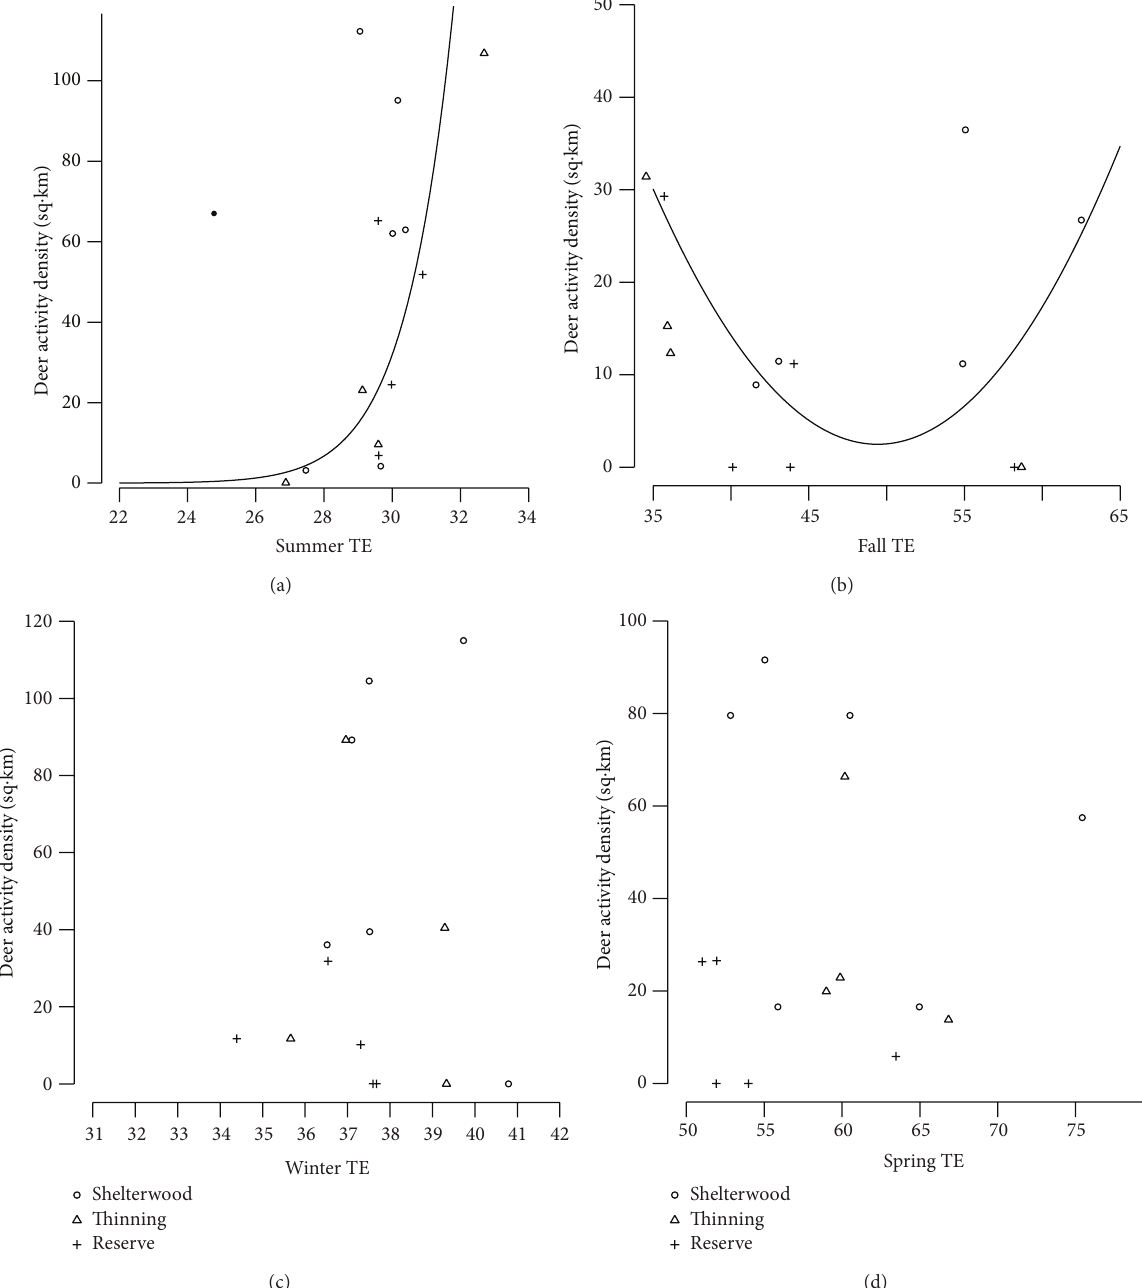
Figure 2: Relationship between the thermal environment ( TE ) and deer activity density at YMF for the (a) summer (May–August), (b) fall (September–October), (c) winter (November–January), and (d) spring seasons (February-March). Regression lines are provided when significant models were produced. The black point in panel (a) indicates an outlier that was removed from analysis.